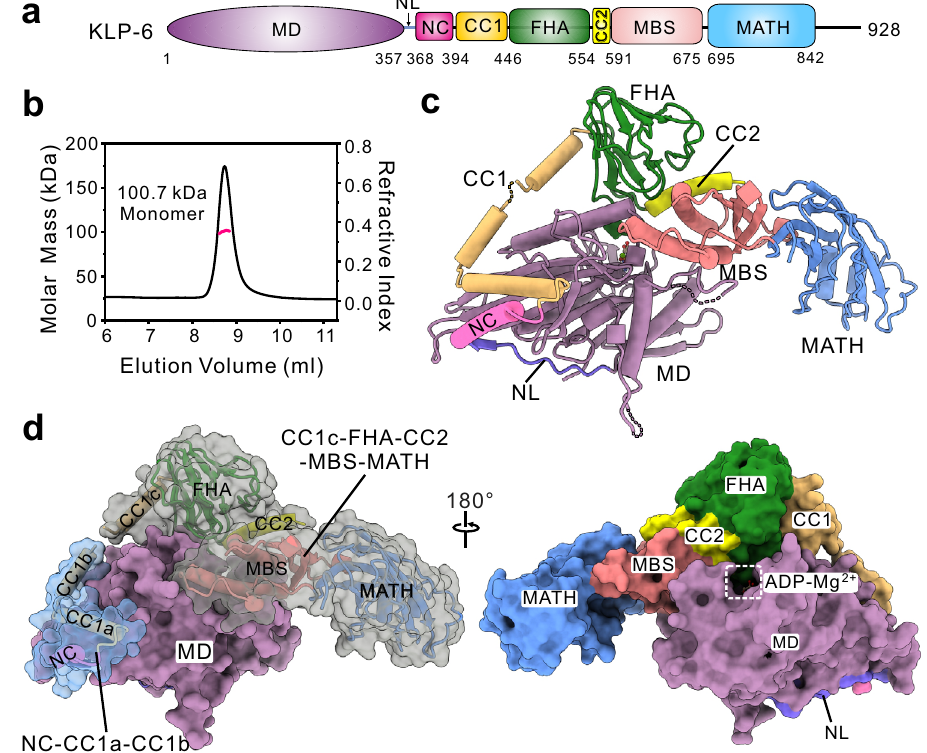
Fig. 1 | Overallstructure of full-length KLP-6.a Domain organizationofkinesin-3 KLP-6. KLP-6 contains an N-terminal MD, a neck domain (composed of the NL and NC), the CC1-FHA-CC2 tandem followed by a MBS domain, and a newly identi fi